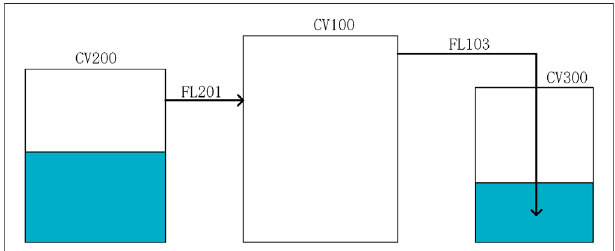
FIGURE 2 | MELCOR model nodalization of the experimental facility.